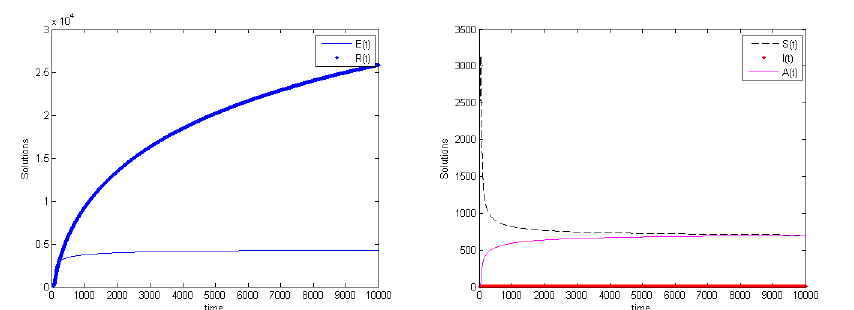
Figure 3. The model behavior for 0 < R 0 = 0.0571 < 1. ( Left ) susceptibles reach the level of 5500; ( Right ) infected and asymptomatic individuals are reduced to the single digits, essentially vanishing, recovered and exposed individuals remain confined respectively around the levels 100 and 50. In this situation, the system approaches the disease-free equilibrium P 0 . The parameter values are Λ = 500, β I = 0.0005, k = 0.1, d p = 0.082, α = 0.15, ω p = 0.1, ω (cid:48) p = 0.1, ξ = 0.1, µ = 0.001, γ p = 1.764, γ (cid:48) p = 0.6024, ν = 0.0005.